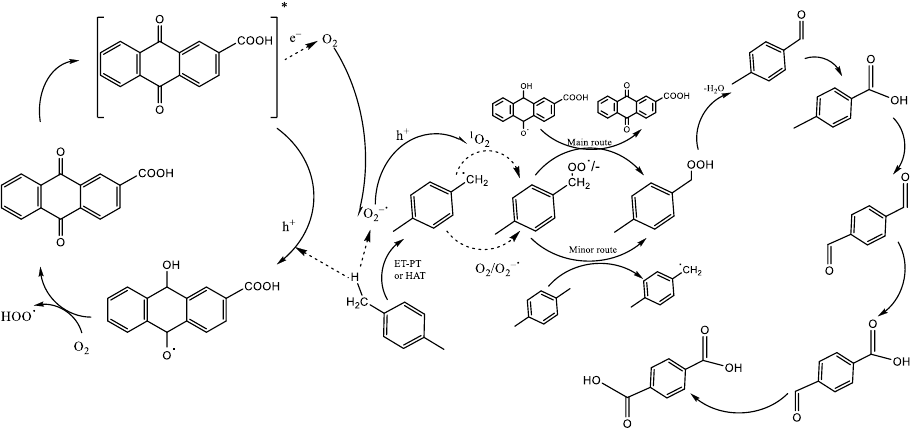
Table 1. Reaction conditions and best results for homogeneous catalysts focused on the oxidation of p- xylene or